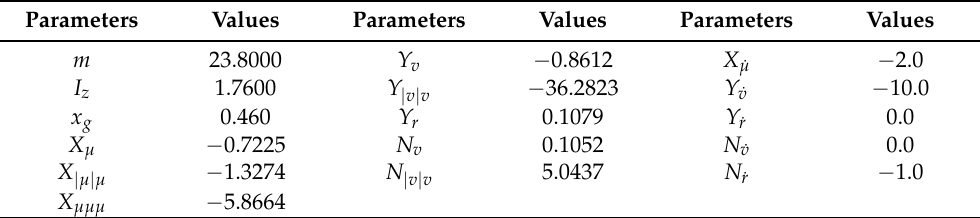
Table 2. Main parameters of the CyberShip II model.